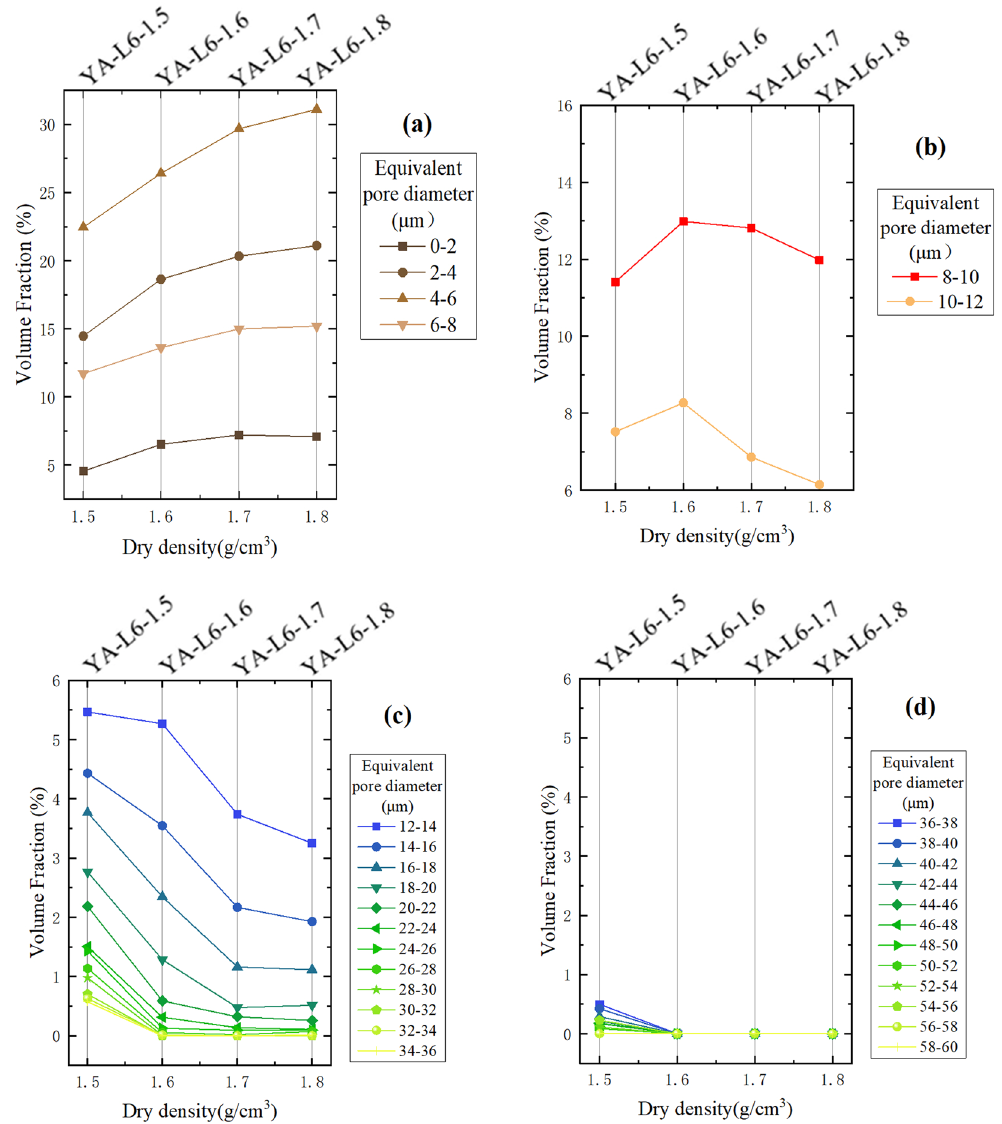
Figure 3. Volume fraction obtained from CT scanning for different equivalent pore diameter vs. dry density of the compacted loess samples: (a) pores with an equivalent diameter of 0~8 μ m; (b) pores with an equivalent diameter of 8~12 μ m; (c) pores with an equivalent diameter of 12~36 μ m; (d) pores with an equivalent diameter larger than 36 μ